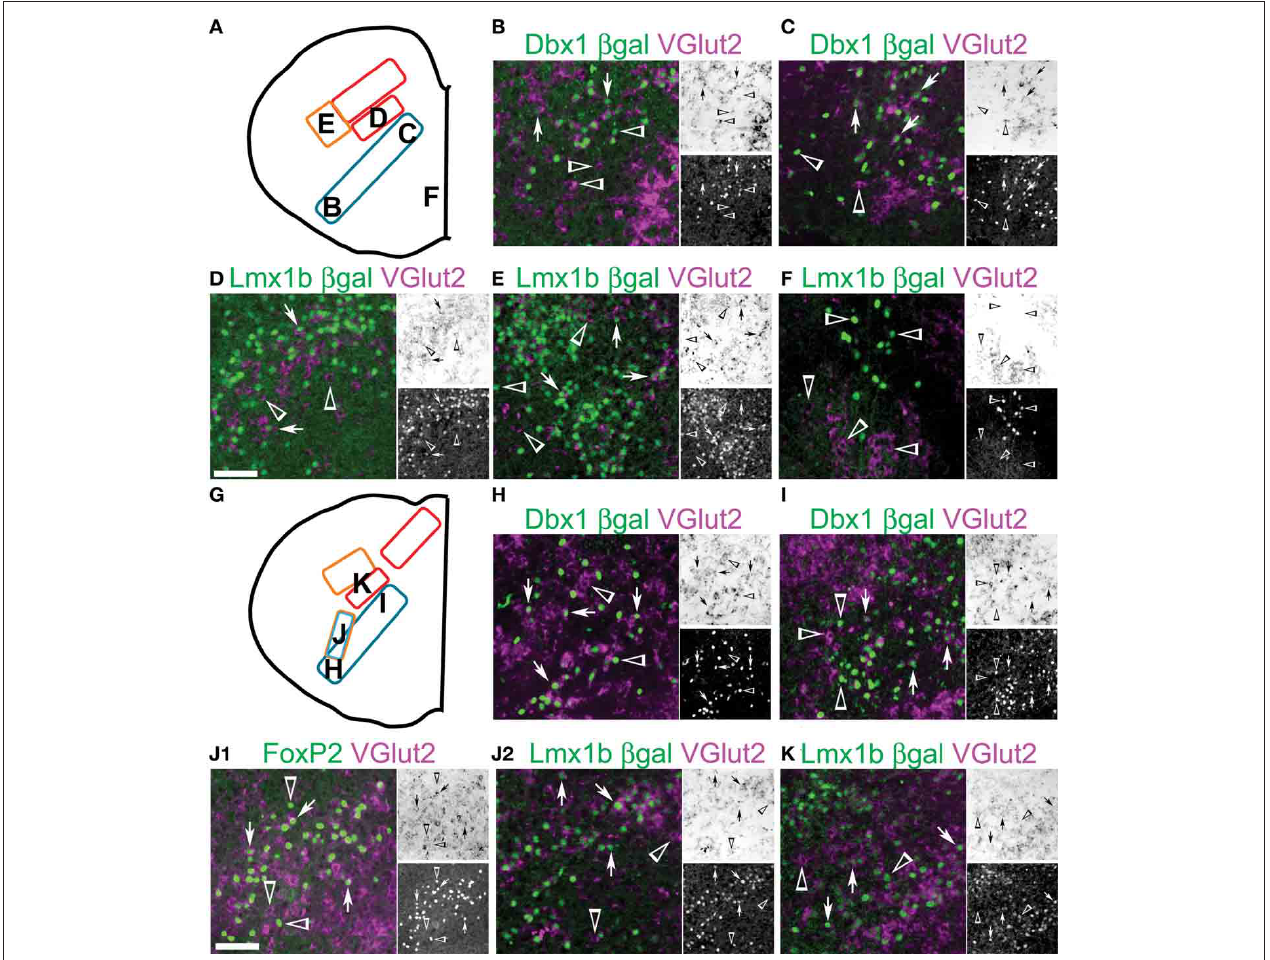
FIGURE 9 | Developmental origin of medullary reticular formation glutamatergic neurons. Schematic image modified from Figure 2E (A) or from Figure 2G (G) indicating location of glutamatergic populations of pr8 (B-F) or pr9 (H-K) . (B-F, G-K) Images showing inverted VGlut2 mRNA (magenta), β gal (green), and FoxP2 (J1 , green ) from Dbx1- β gal